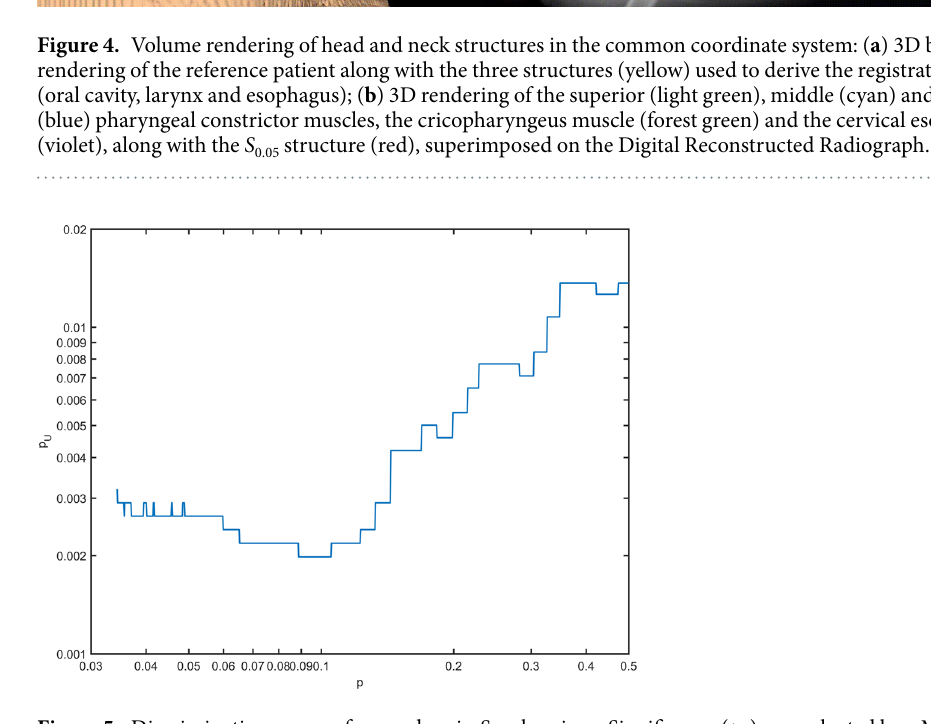
Figure 5. Discriminating power of mean dose in S p subregions. Significance ( p U ), as evaluated by a Mann- Whitney U test, of the mean dose differences on S p between patients who developed toxicity and who did